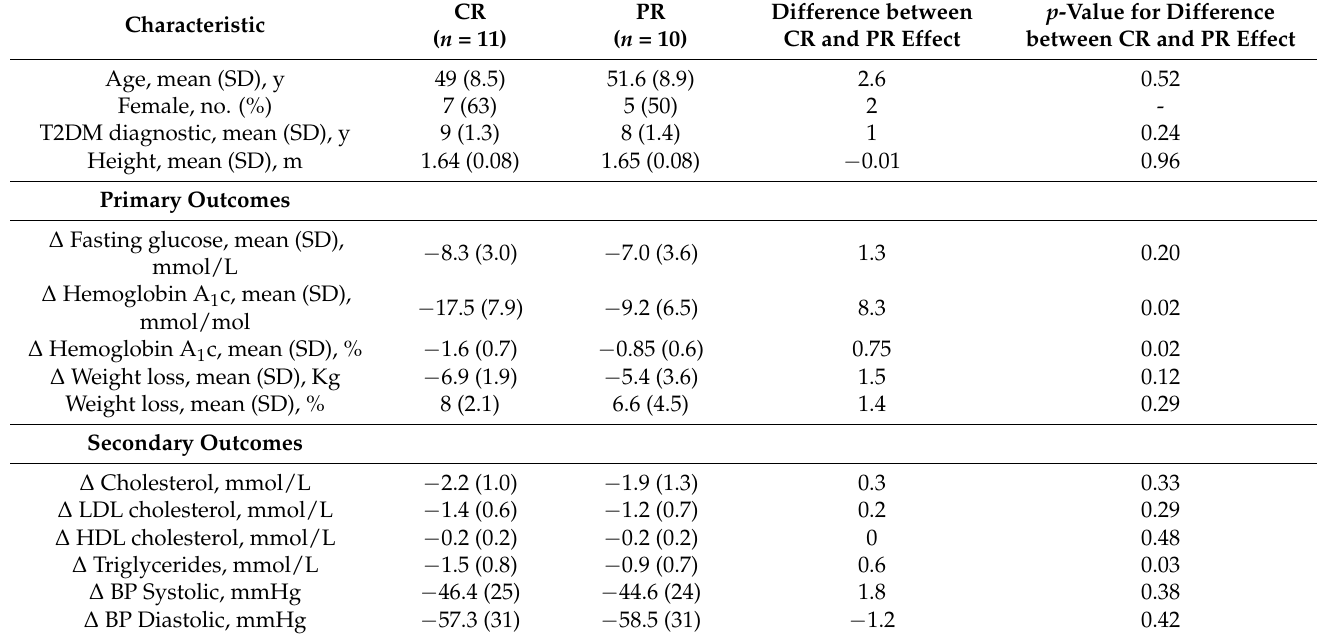
Table 1. General characteristics of the subjects and primary and secondary outcomes by CR and